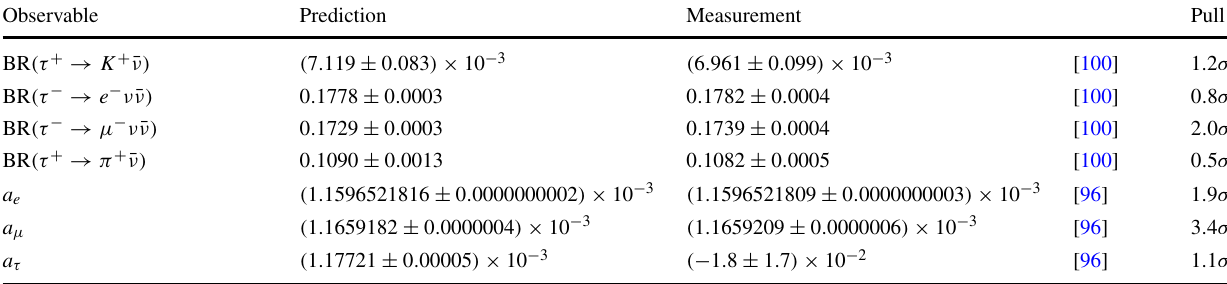
Table 3 Leptonic observables where theory uncertainties are taken into account Observable